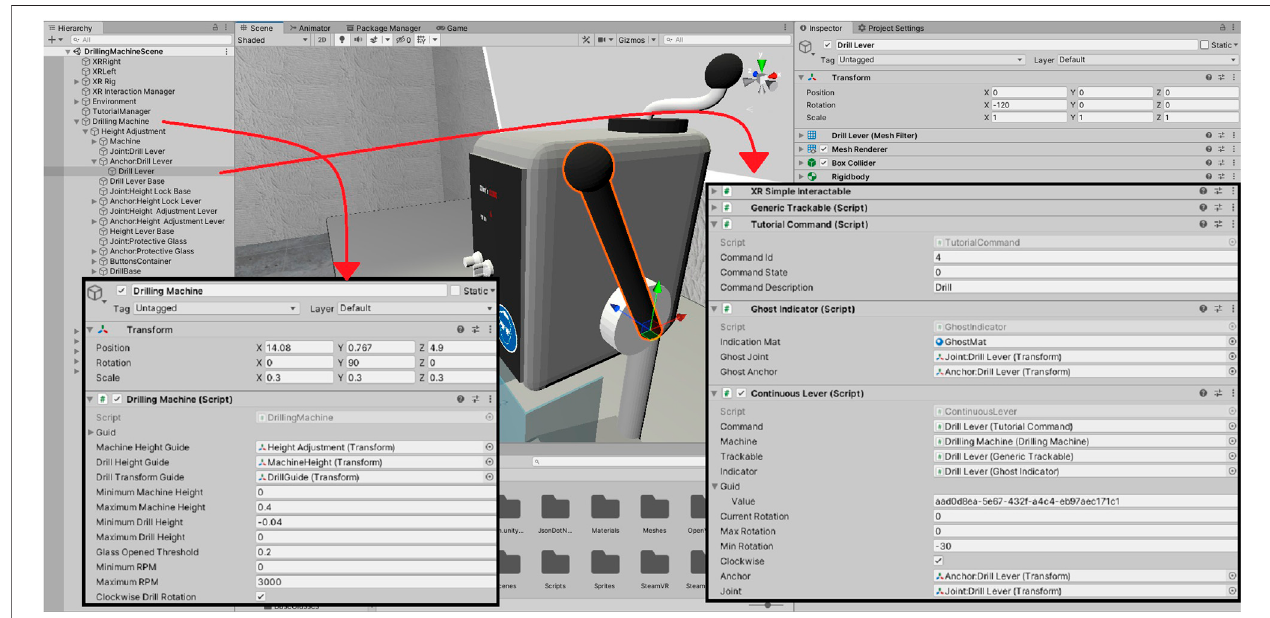
FIGURE 2 | Example of the interface of some components. The drilling machine is customized by the designer. The drill lever game-object contains a trackable component, a ghost indicator, a tutorial command and the continuous lever interactable component with its appropriate public settings exposed on the inspector.